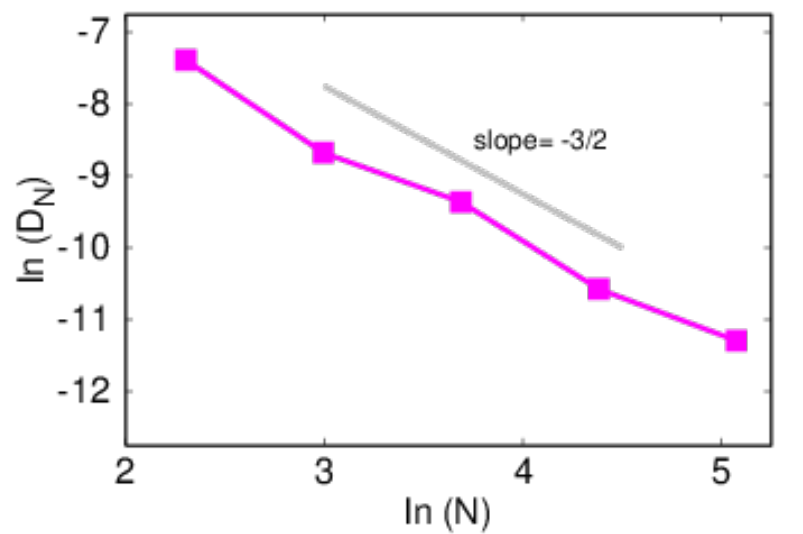
Figure 10. Size dependence of the diffusion coefficient for a polymer initially attached to an impurity. Gray line represents expected slope